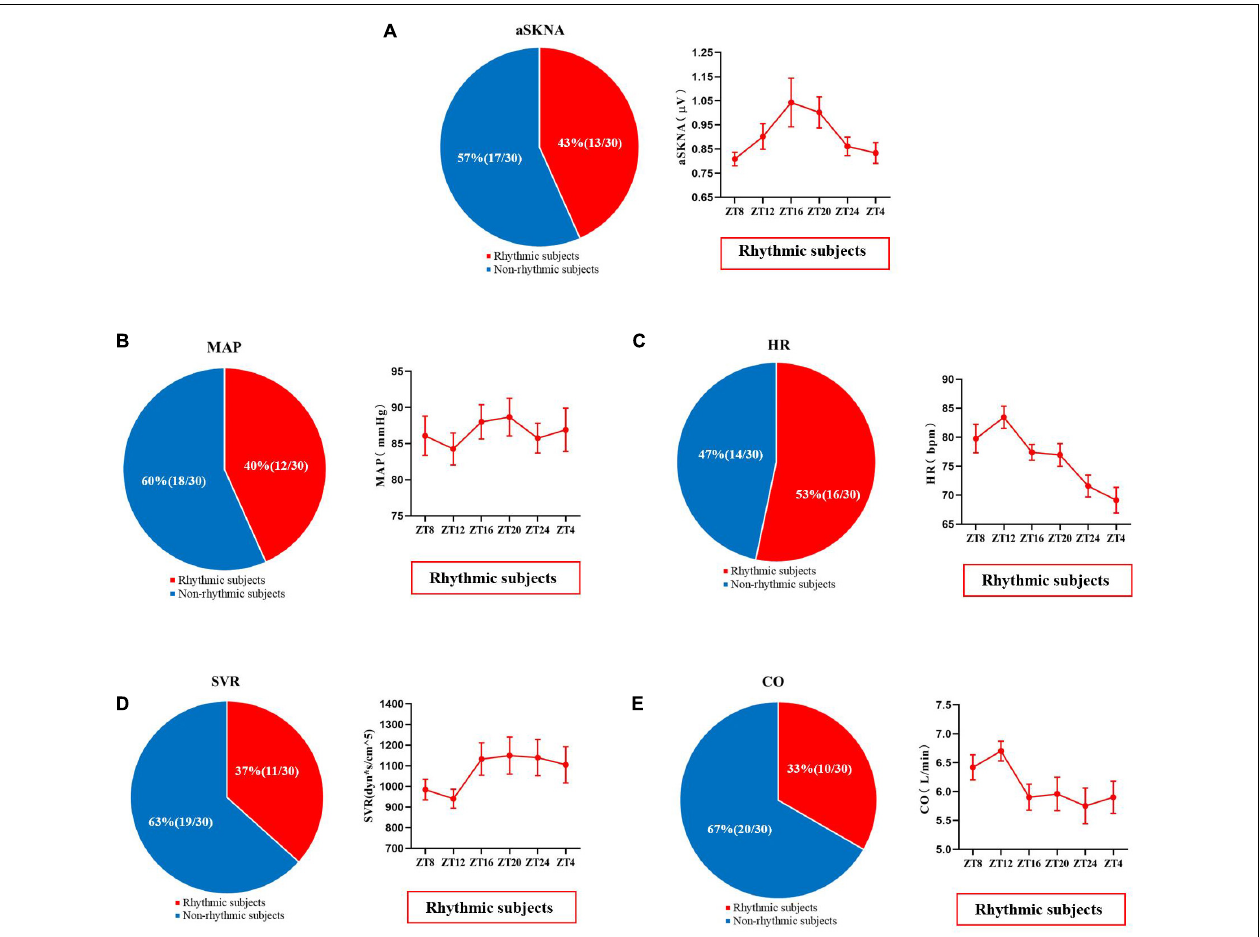
FIGURE 6 | The proportion of skin sympathetic nerve voltage (A) , mean arterial pressure (B) , heart rate (C) , peripheral vascular resistance (D) , and cardiac output (E) in subjects with or without significant periodic signal. Red represents the population with significant periodic signal, and blue represents the population without significant periodic signal. The change trend of the measured values with significant periodic signal is shown. Values are presented as mean ± standard error. aSKNA, average skin sympathetic nerve activity; MAP, mean arterial pressure; HR, heart rate; SVR, systemic vascular resistance; CO, cardiac